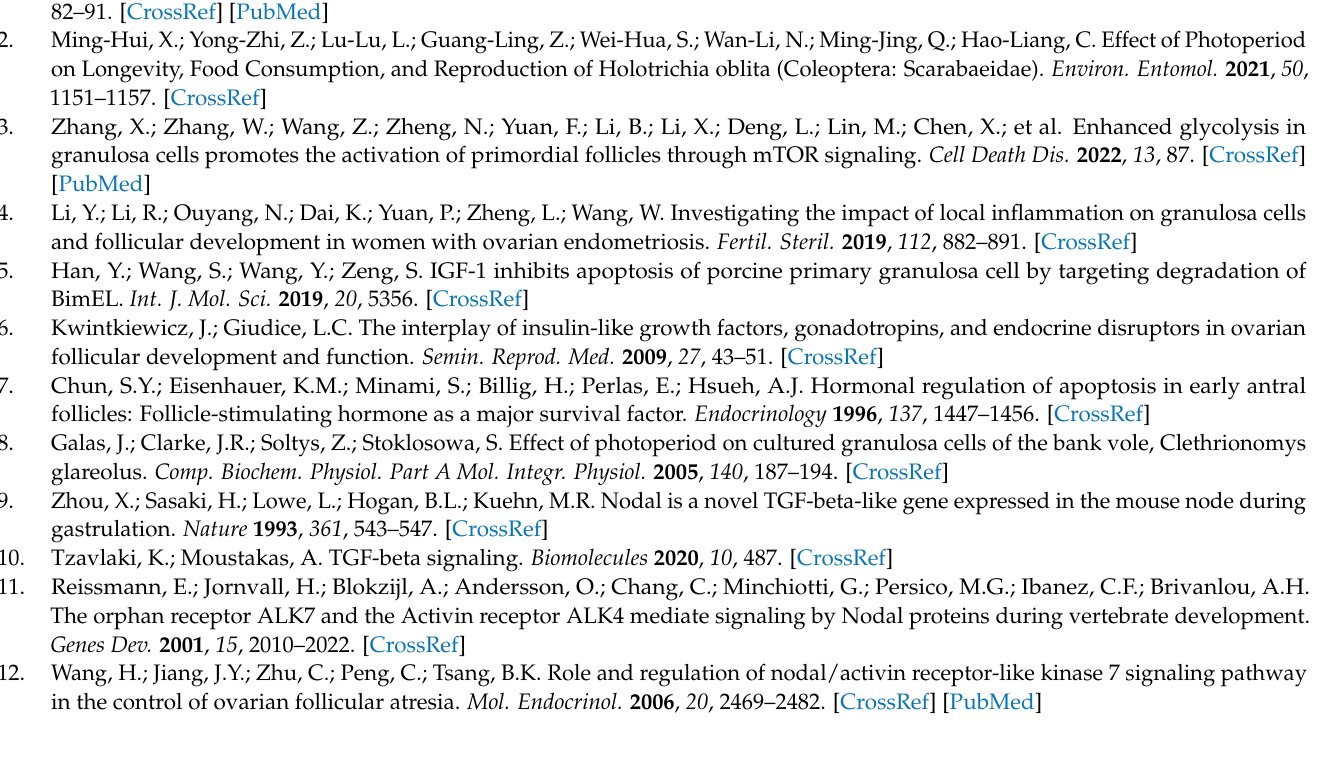
information. Table S3: Detailed information of the western blotting antibody. Table S4: Numbers of growing follicles in each section under different photoperiods, with the same magnification. Table S5: Numbers of antral follicles in each section under different photoperiods, with the same magnifica- tion. Table S6: Numbers of atretic follicles in each section under different photoperiods, with the same